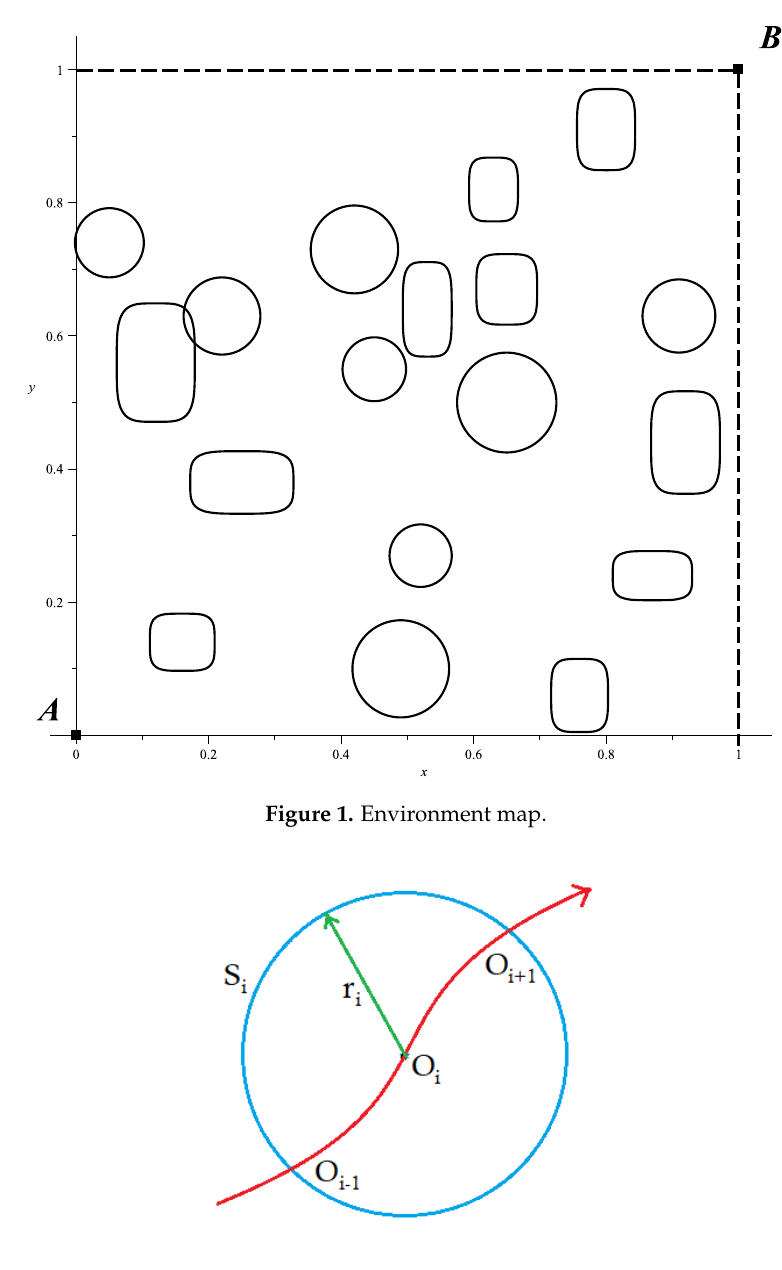
Figure 2. Hyperspherical Algorithm Representation for two